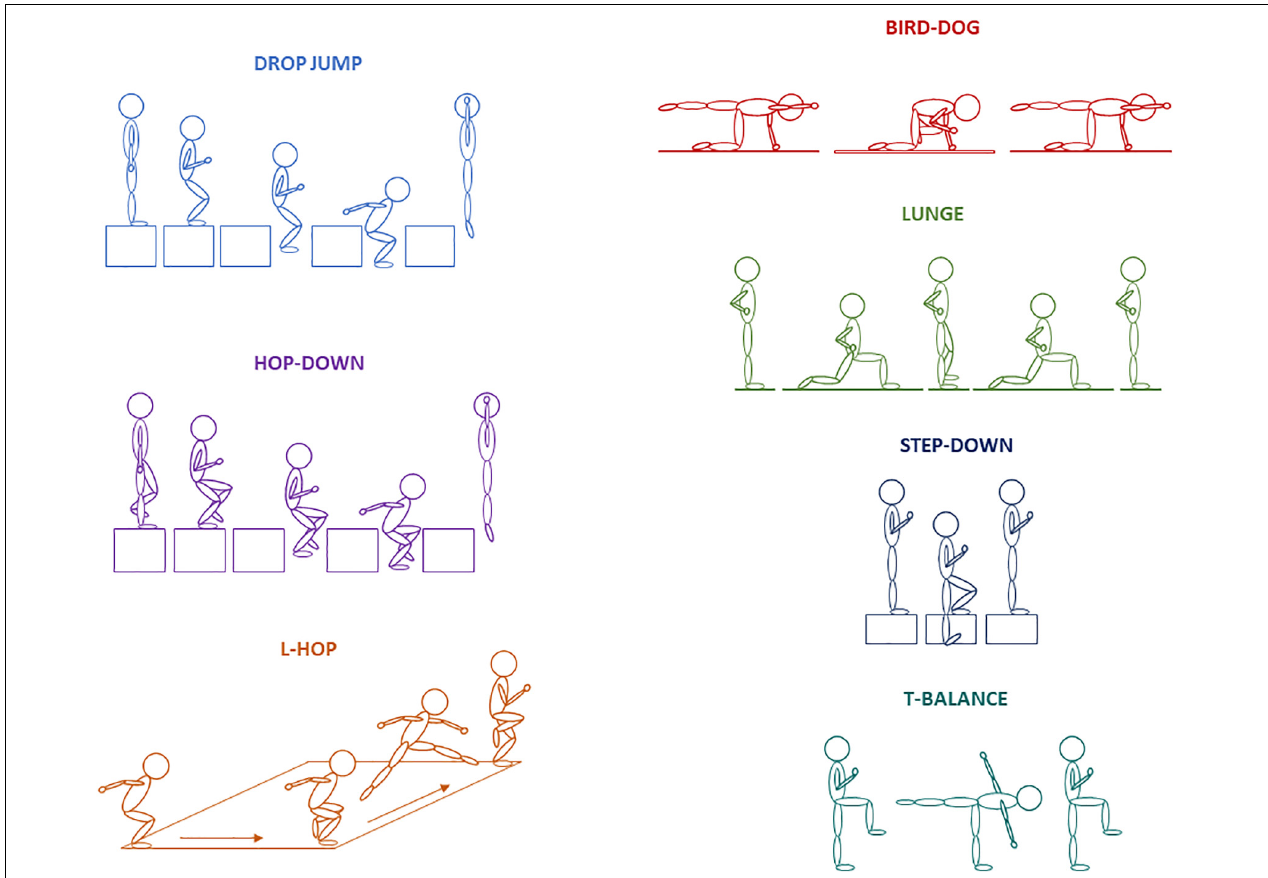
FIGURE 1 | Schematic drawings of the seven unique movements performed by the athletes: drop-jump, hop-down, L-hop, bird-dog, lunge, step-down, and T-balance.